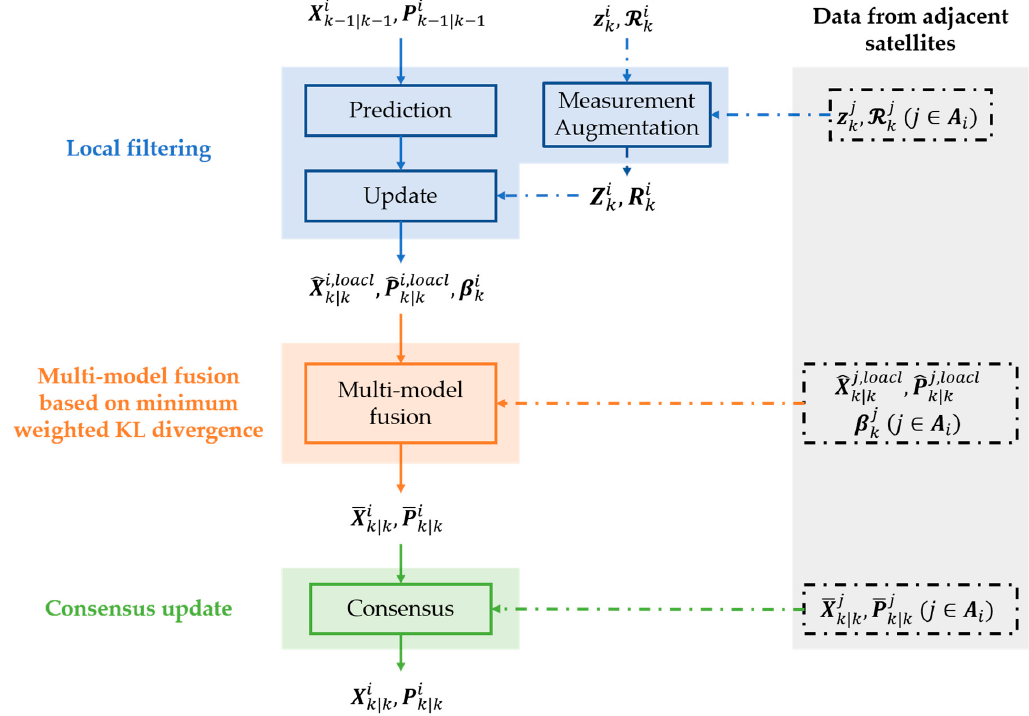
Figure 3. The operation flow of satellite 𝑠 (cid:3036) , from time 𝑘 − 1 to time 𝑘.